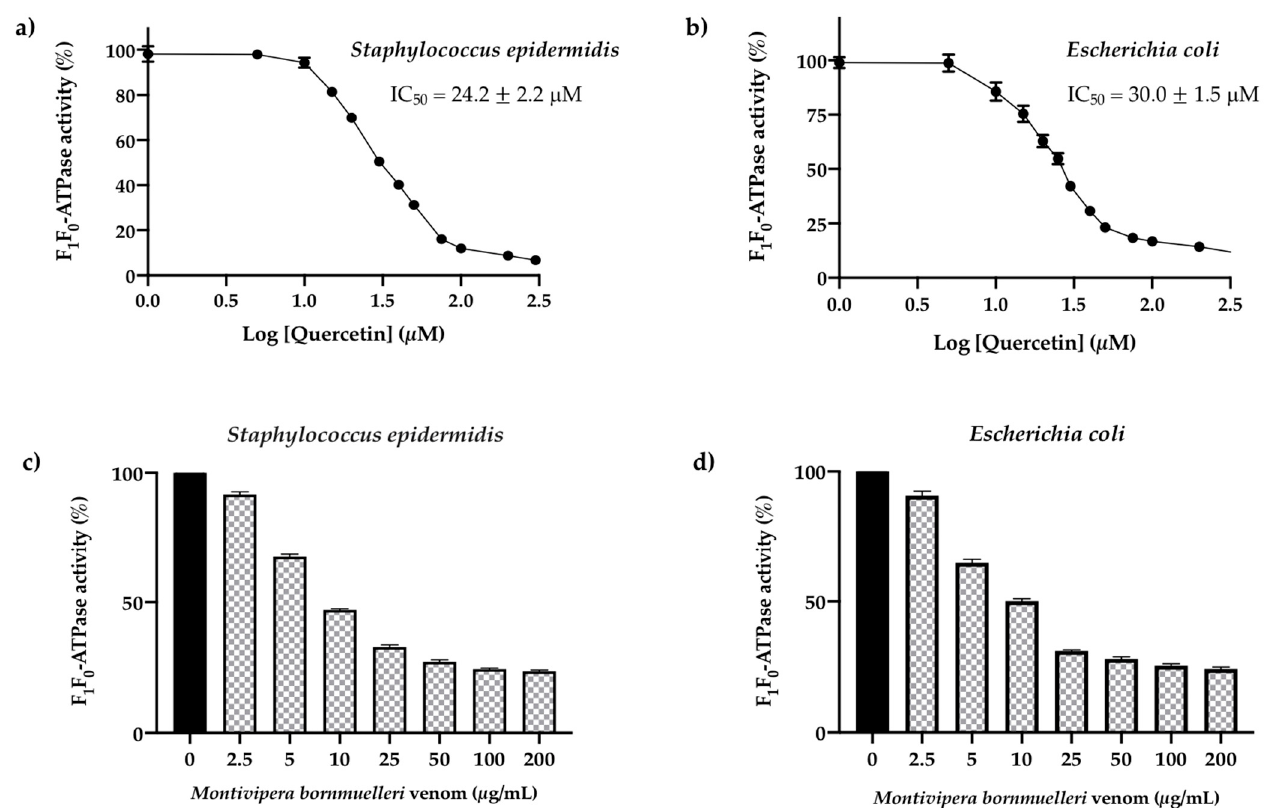
Figure 2. Effect of the M. bornmuelleri venom on the F 1 F 0 -ATPase enzymatic activities of S. epidermidis and E. coli bacteria strains. The IC 50 of the quercetin—used as an inhibitory reference ligand—on the enzymes is shown. ( a ) Dose-response curve showing the F 1 F 0 -ATPase activity (%) of S. epidermidis as a function of the log of the concentration of quercetin. ( b ) Dose-response curve showing the F 1 F 0 -ATPase activity (%) of E. coli as a function of the log of the concentration of quercetin. ( c ) Histogram representing the effect of M. bornmuelleri venom ( µ g/mL) on the activity (%) of membrane-bound S. epidermidis F 1 F 0 -ATPase. ( d ) Histogram representing the effect of M. bornmuelleri venom ( µ g/mL) on the activity (%) of membrane-bound E. coli F 1 F 0 -ATPase. For the four graphs represented here, the error bars show the standard deviation obtained from experiments carried out in triplicate. Data are expressed as mean ± SD (n = 3). Quercetin was used as a positive control. One-way ANOVA test: ns (not significant), when compared with the control. The M. bornmuelleri venom exerts a dose dependent inhibition on ATPase activity.